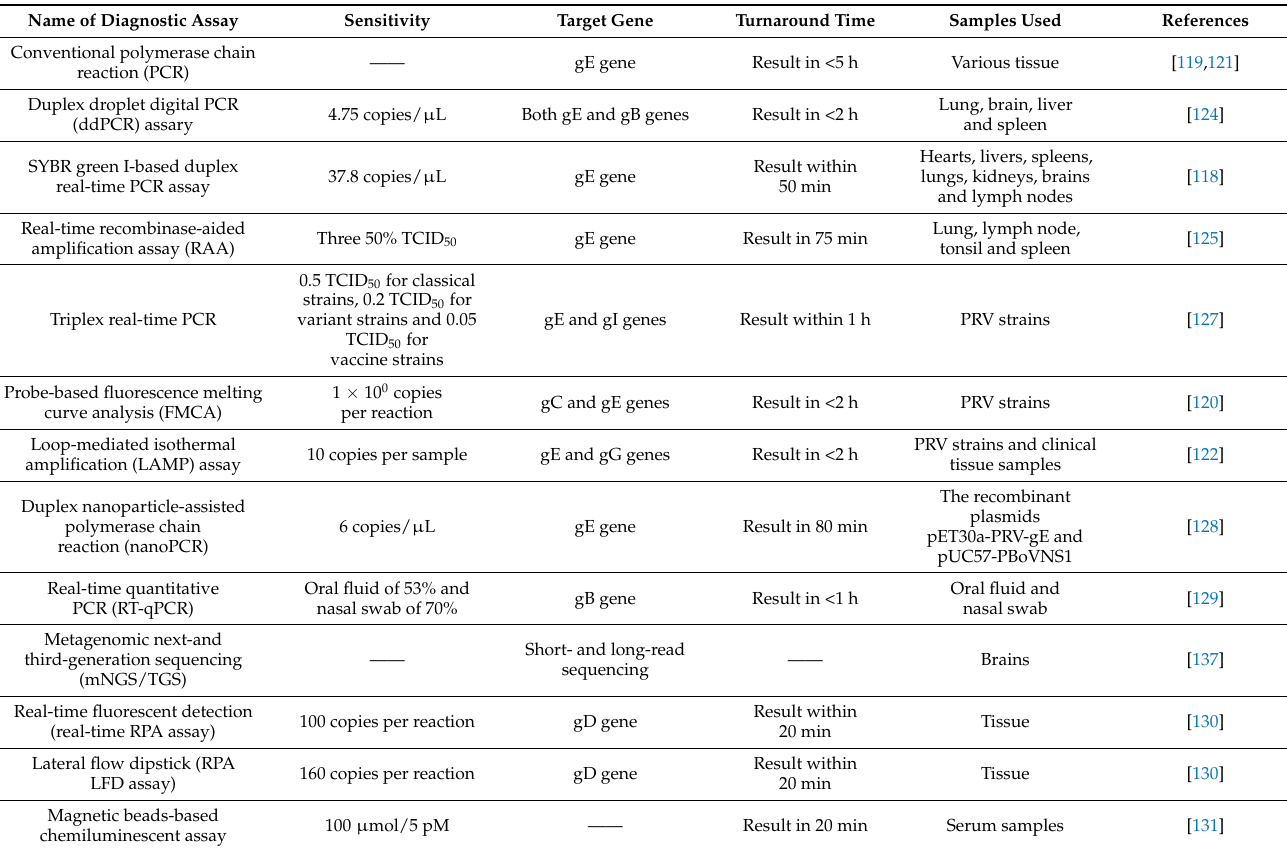
Table 2. List of molecular diagnostic methods of PRV